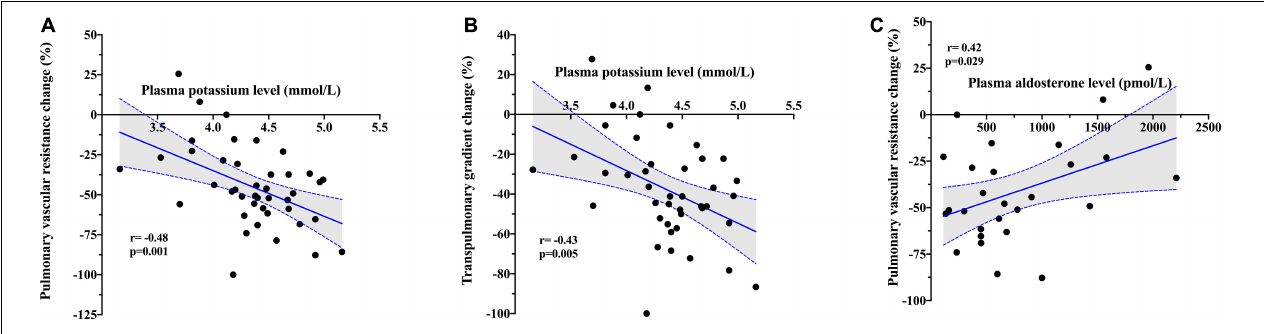
FIGURE 2 | Correlation between baseline plasma potassium level and (A) relative change in pulmonary vascular resistance and (B) relative change in transpulmonary gradient after PDE5i. (C) Correlation between baseline plasma aldosterone level and relative change in pulmonary vascular resistance after